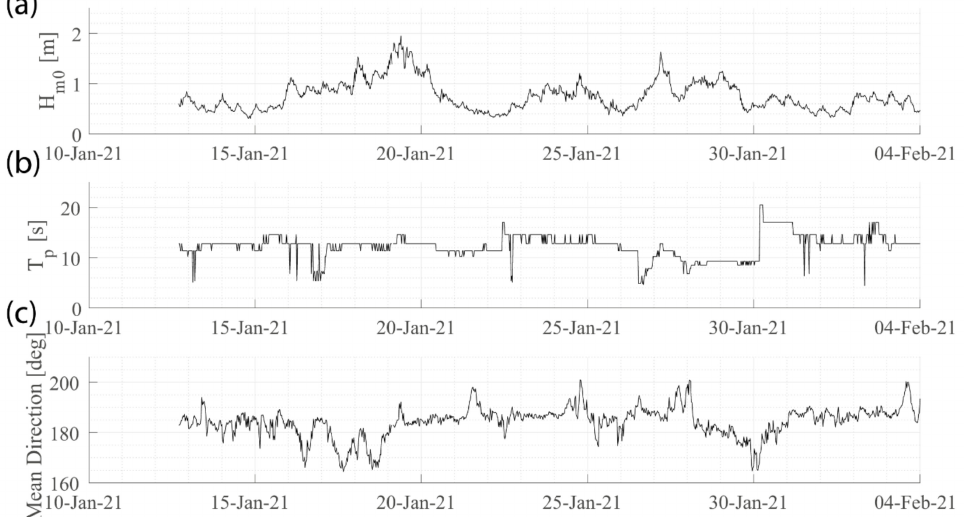
Figure 5. Spotter wave data between 12 January 2021 and 4 February 2021 showing time series of ( a ) the spectral significant wave height (H m0 ), ( b ) the peak wave period (T p ), and ( c ) the mean wave